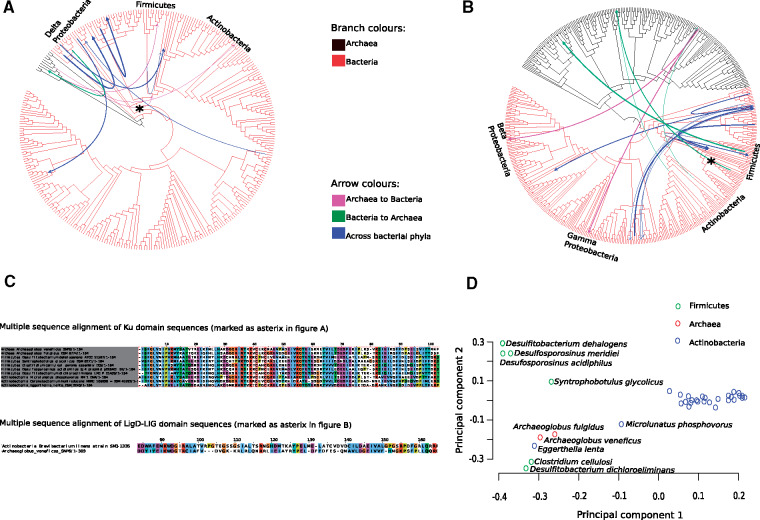
Extensive HGT among bacterial phyla and between bacteria and archaea. 16S rRNA-based species tree depicting the most frequent donor–recipient pairs involved in (A) Ku HGT events and (B) LigD-LIG HGT events. The bacterial species included in both the species tree coded for one Ku and one LigD only. The archaeal species were included 1) in (A) if they had at least a Ku and 2) in (B) if they had at least a LigD-LIG domain (see Materials and Methods for more details). The width of the arrow corresponds to the number of reconciliations supporting a given transfer event (see supplementary files 3 and 4, Supplementary Material online, for exact number of reconciliations for each donor–recipient pair). (C) Ku domain MSA (upper panel) of prokaryotes belonging to genus Archaeoglobus and phyla Firmicutes and Actinobacteria included in (A) (transfer event marked as asterisk). LigD-LIG pairwise alignment (lower panel) of an Archaea–Actinobacteria HGT transfer event in (B) (marked as asterisk). (D) Principal component analysis of Ku domain sequences evolved from ancestors included in transfer event in (A) (marked as asterisk).